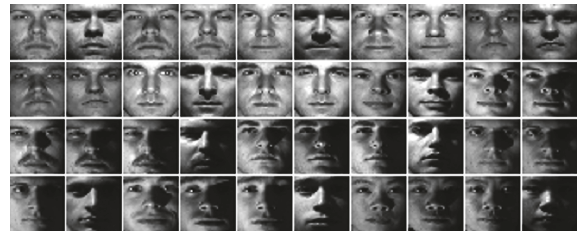
Figure 1: Examples of the Extended YaleB